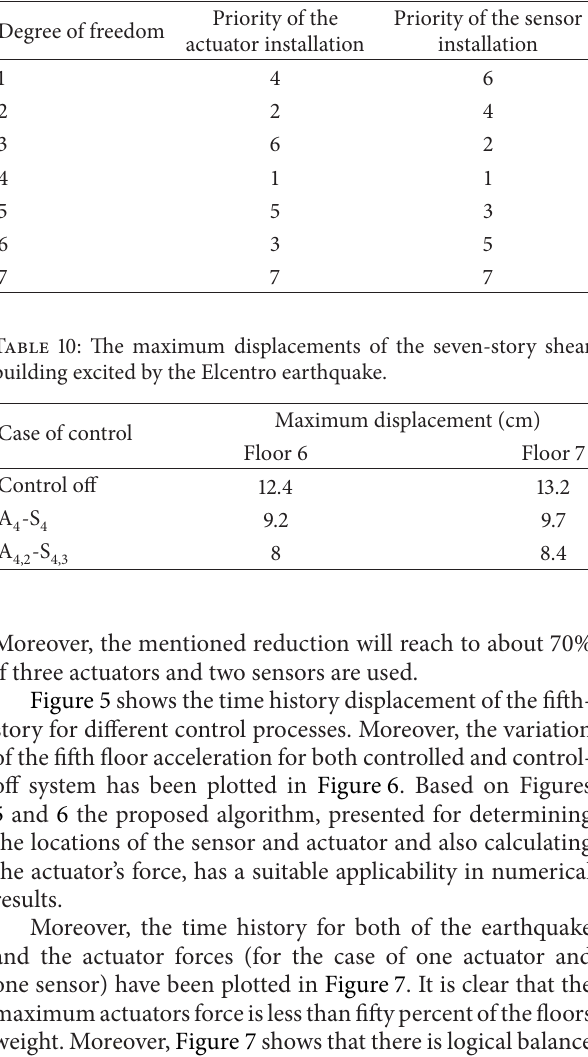
Table 9: The actuator and sensor locations for seven-story shear building.